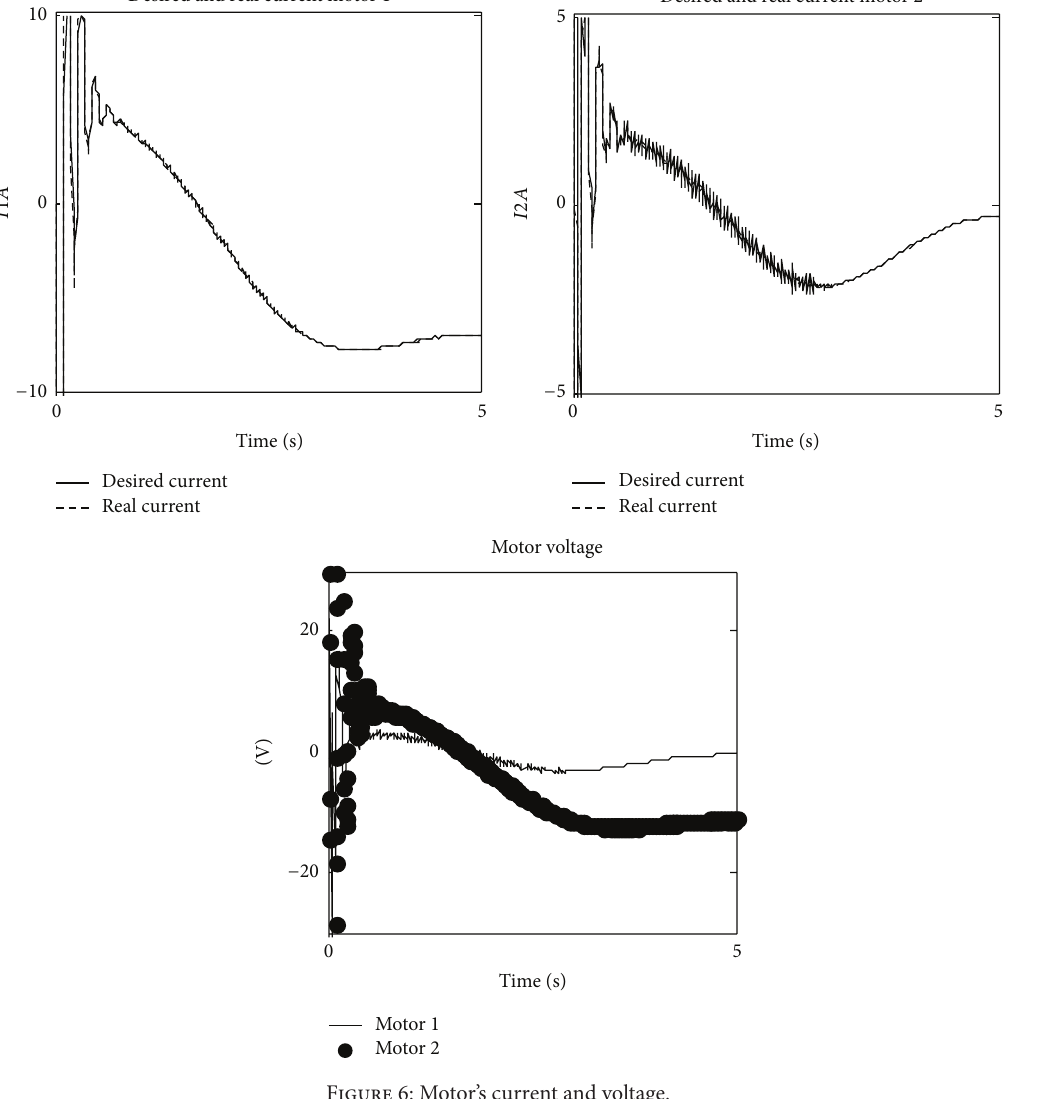
Figure 6: Motor’s current and